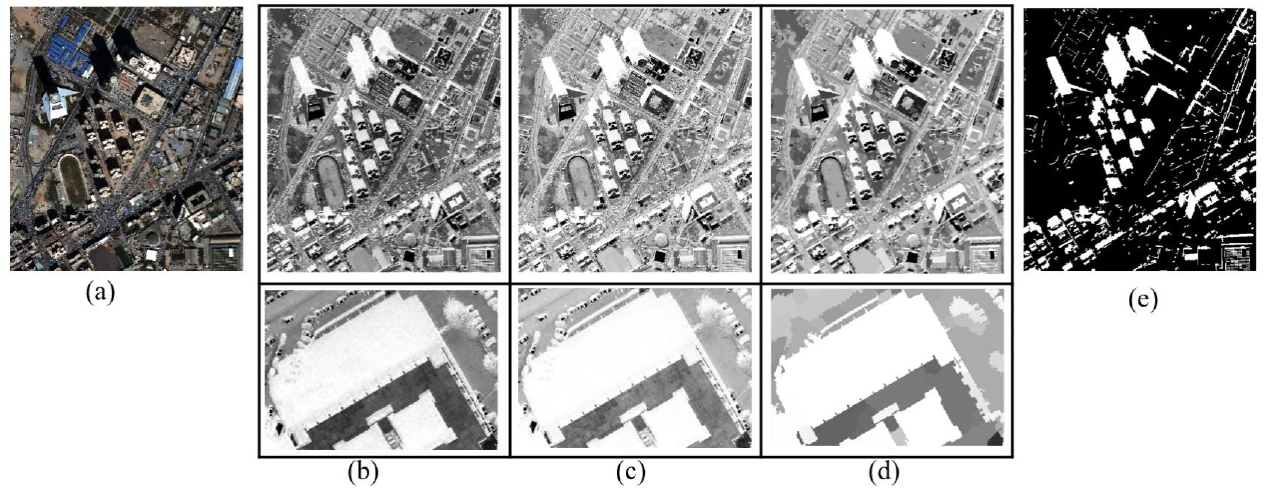
Figure 9. Experimental site 1: ( a ) original image shown with RGB bands; the first rows of ( b – d ) are the results of SI, ISI and the reconstructed ISI, respectively; the second rows of ( b – d ) are the local enlarged view of SI, ISI and the reconstructed ISI, respectively; and ( e ) the result of shadow detection after threshold segmentation.